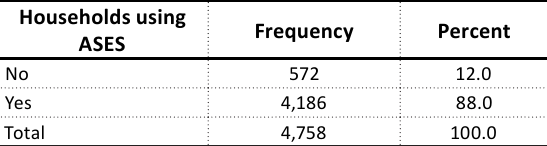
Table 9. Proportion of households using